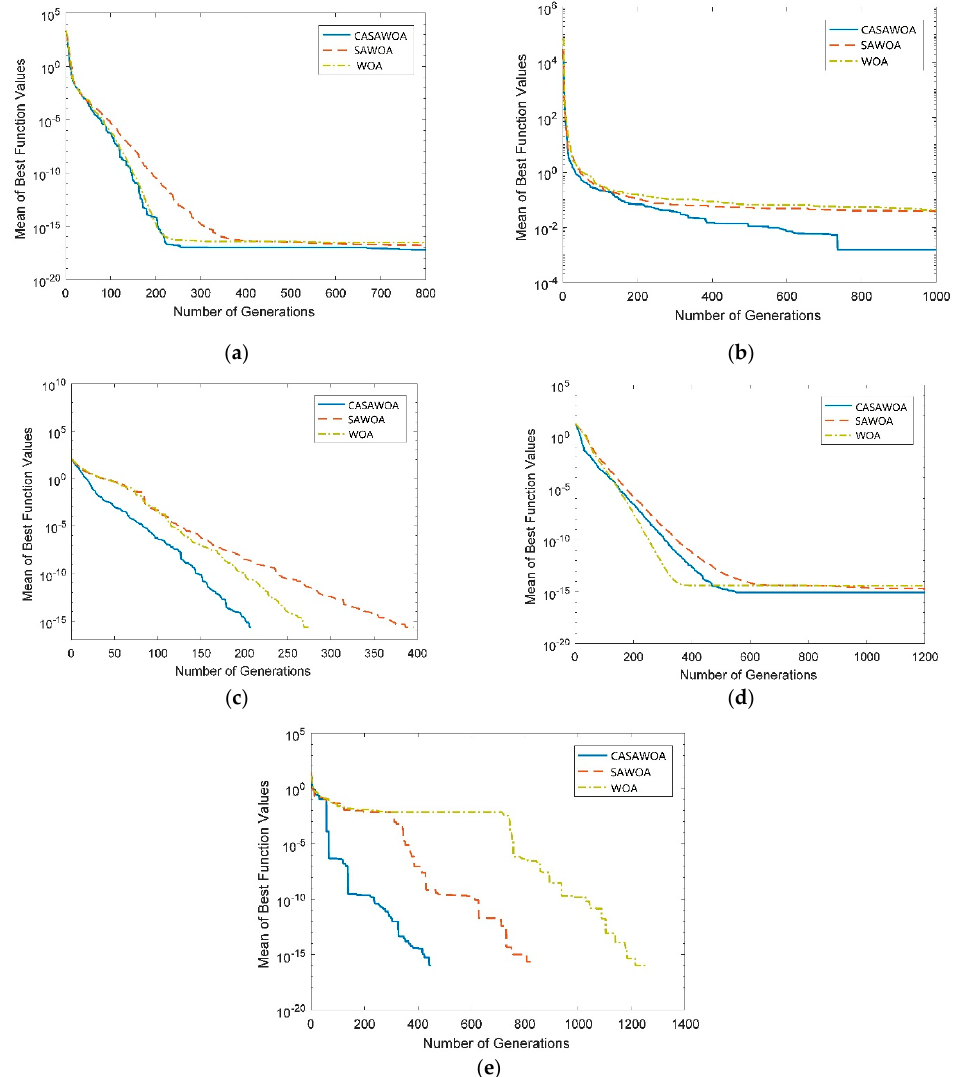
Figure 4. CASAWOA convergence speed for benchmarks ( a ) comparative convergence speed of the Sphere function; ( b ) comparative convergence speed of the Rosenbrock function; ( c ) comparative convergence speed of the Rastrigin function; ( d ) comparative convergence speed of the Ackley function; and ( e ) comparative convergence speed of the Griewank function. From the figures presented, the CASAWOA not only achieves better results in all the test functions, it also outperforms SAWOA and WOA in terms of convergence speed in the Griewank, Rastrigin, and Rosenbrock functions. For the Ackley function, CASAWOA has a better best-mean-value than WOA and SAWOA but has a lower convergent speed than WOA.